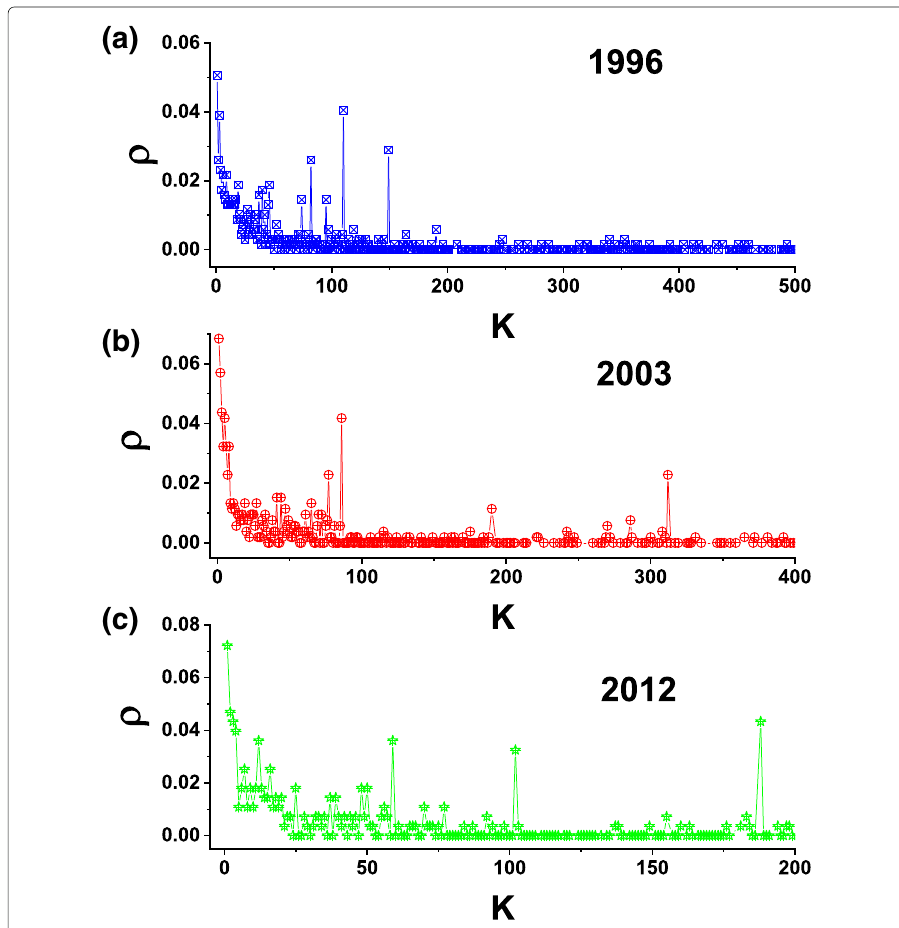
Fig. 8 The risk ratio, ρ , and number of nodes N in K -shell as a function of K for ( a , b ) 1996, ( c , d ) 2003 and ( e , f ) 2012